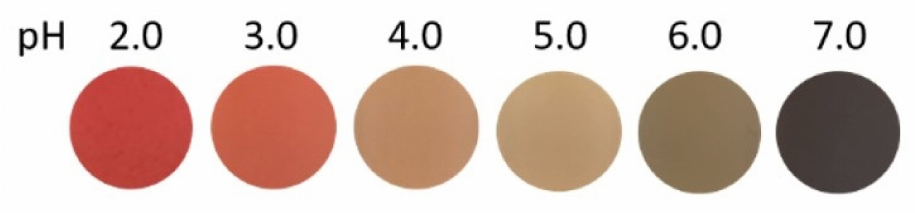
Figure 1. Photographs of the anthocyanin solution showing the colorimetric response to lactic acid at different pH